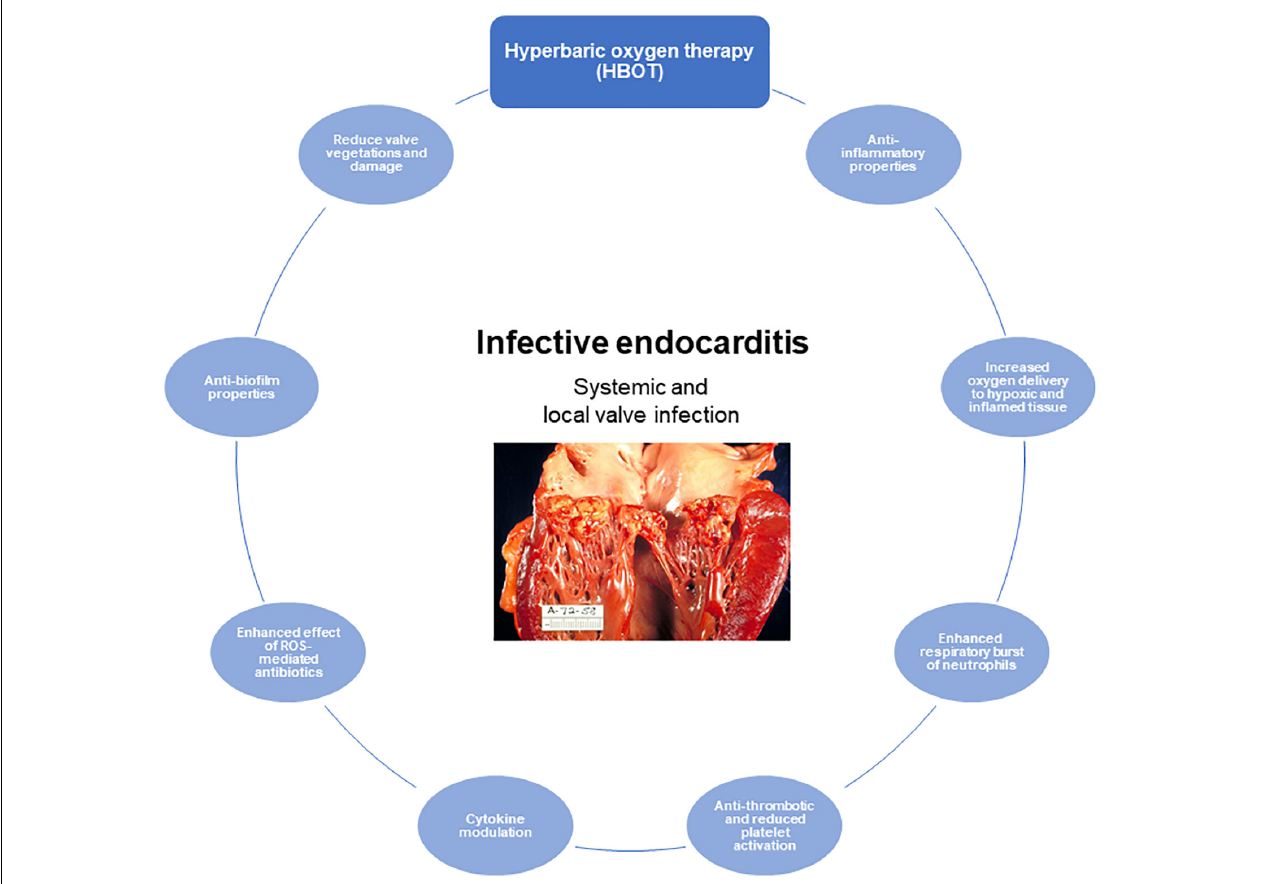
FIGURE 5 | The role of hyperbaric oxygen treatment (HBOT) of infective endocarditis (IE). Proposed and important effects of HBOT in IE. Illustration of human IE reused with permission from Wikimedia Commons, the free media repository.